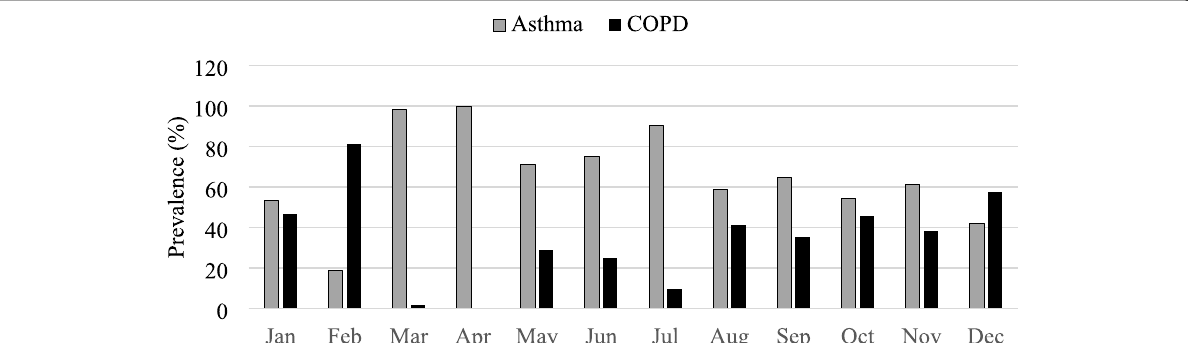
Fig. 2 Monthly comparative percentage prevalence of asthma and chronic obstructive pulmonary disease (COPD) in the District Dera Ismail Khan in